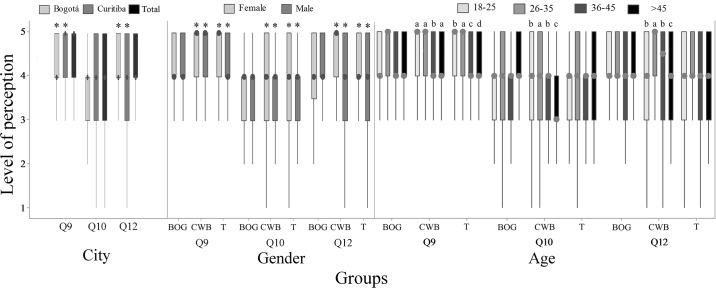
Perception of suffering in slaughter (Q9), meat quality (Q10) and regulation (Q12) by 782 citizens of Bogotá and Curitiba, 2014/2015.Data for city, gender and age; 1 = certainly not and 5 = certainly yes; the asterisk indicates gender difference (P<0.05, Mann-Whitney); letters indicate differences between age groups (P<0.05, Kruskal-Wallis and Dunn Test).